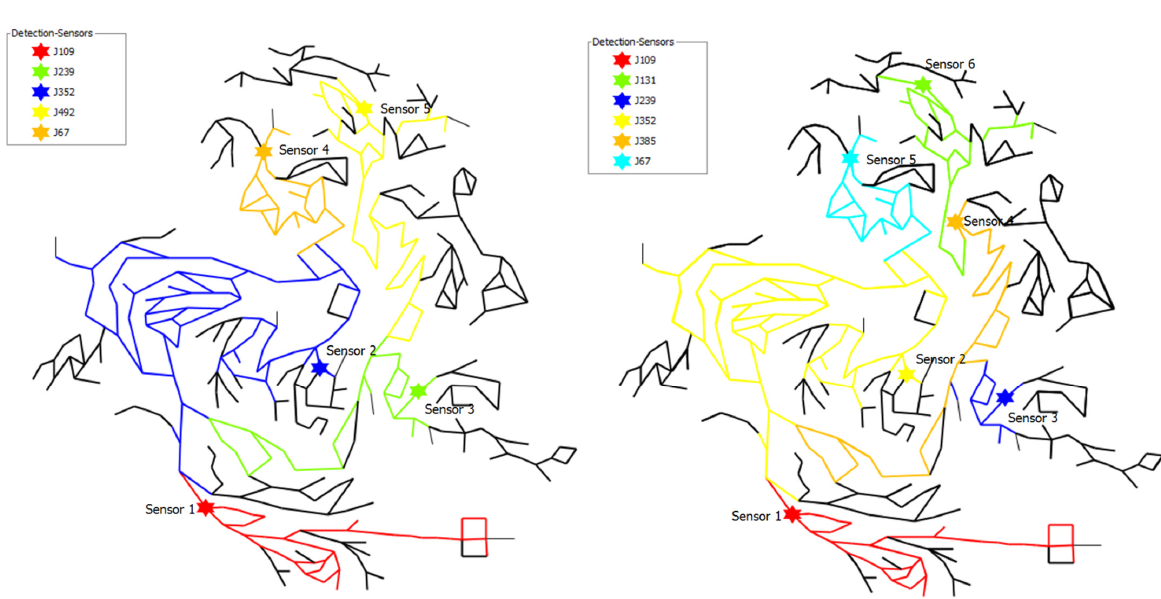
Figure 3. OCMS designs generated with TEVA-SPOT for 𝜂 (cid:3047)(cid:3042)(cid:3047)(cid:3028)(cid:3039) = 5 ( left ) and 6 ( right ).